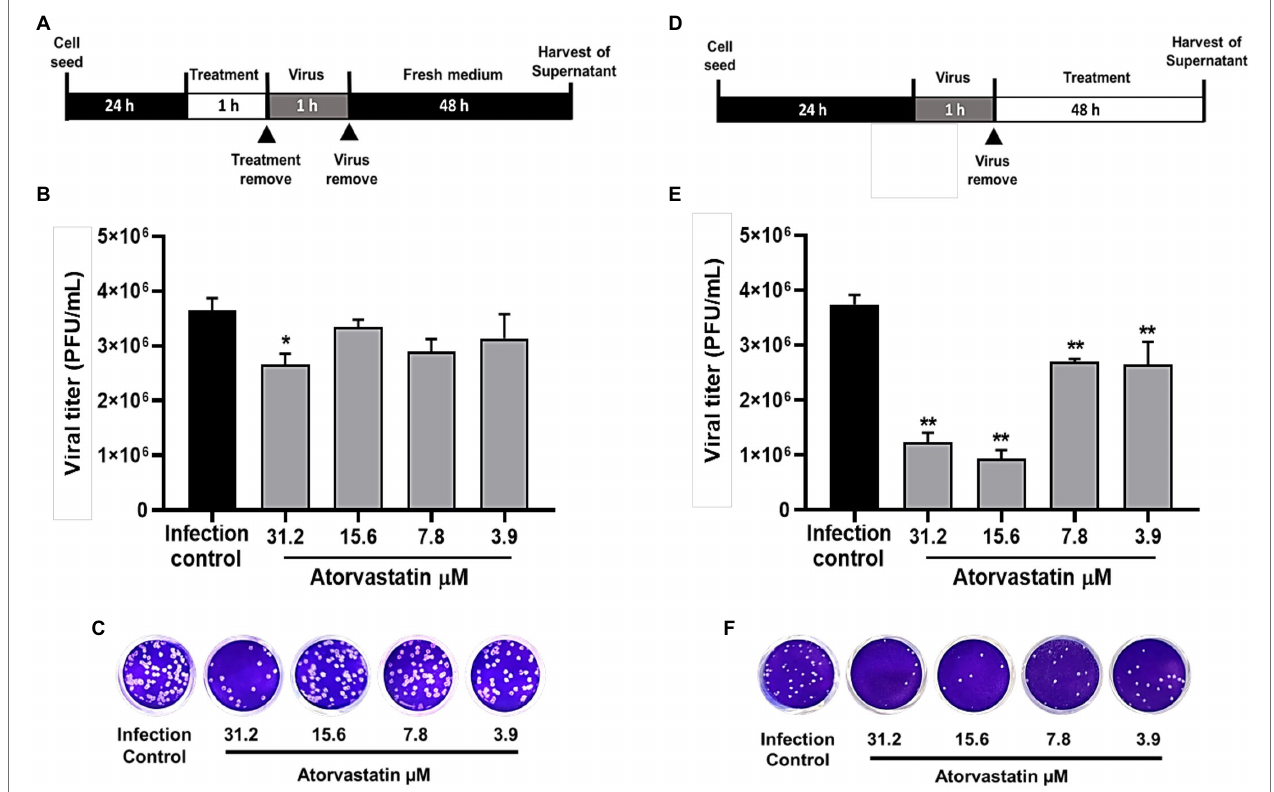
FIGURE 3 | ATV inhibited D614G strain during pre-infection and post-infection treatment. (A) Schematic representation of the pre-infection treatment. (B) Reduction of the D614G strain titer (PFU/ml) in Vero E6 supernatants after pre-infection treatment with ATV. Data were presented as Mean ± SEM ( n = 4). Mann– Whitney test * p ≤ 0.05 and ** p ≤ 0.01. (C) Representative plaques of pre-infection treatment against the D614G strain are shown. (D) Schematic representation of the post-infection treatment. (E) Reduction of D614G strain titer (PFU/ml) in Vero E6 supernatants after post-infection treatment with ATV. (F) Representative images of plaques formed in each treatment condition are shown.